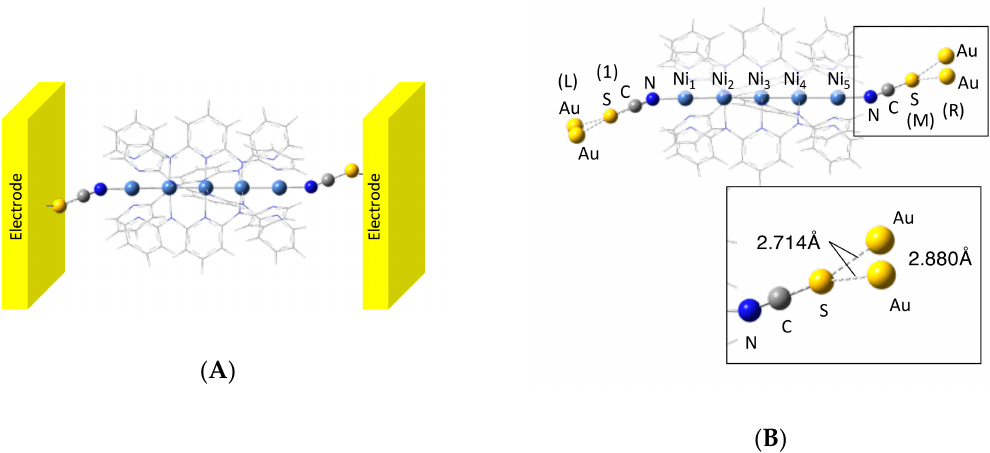
Figure 2. ( A ) Illustration of complex 1 connected to gold electrodes. ( B ) Calculated model system 1 consisting of complex 1 and Au 2 . The labels 1 , M, L, and R in parentheses correspond to those in Equations (1)–(8).